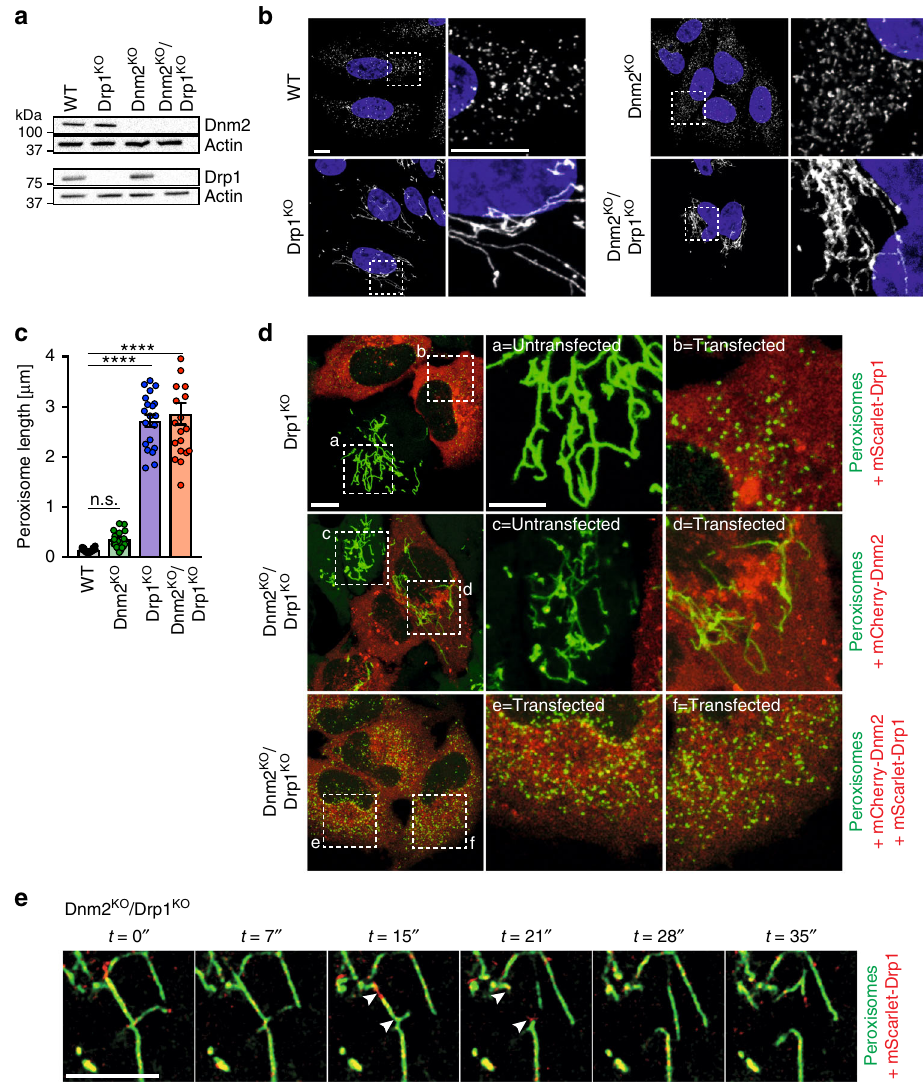
Fig. 1 Loss of Dnm2 does not affect division of peroxisomes. a Western blot analysis of HeLa WT, Dnm2 KO , Drp1 KO , and Dnm2 KO /Drp1 KO whole cell lysates. Actin was used as a loading control. b Confocal images of HeLa WT, Drp1 KO , Dnm2 KO , and Dnm2 KO /Drp1 KO cells subjected to immuno fl uorescence and stained for peroxisomes (Pex14, white). Blue marks the nucleus. An enlargement of the hatched box is shown on the right of each panel. Scale bar = 10 µ m. c Computational quanti fi cation of average peroxisome length in cell lines. n (WT) = 20 cells, n (Dnm2 KO ) = 20 cells, n (Drp1 KO ) = 20 cells, n (Dnm2 KO /Drp1 KO ) = 18 cells. Data obtained from three independent experiments. Data represents the mean ± S.E.M.; n.s., not signi fi cant; **** p < 0.0001. One-way ANOVA with multiple comparisons. d Confocal live-cell image stills of HeLa Drp1 KO and Dnm2 KO /Drp1 KO stably expressing Dendra2-SKL (green) and transfected with mCherry-Dnm2 (red) and/or doxycycline-inducible mScarlet-Drp1 (red) constructs. Enlargements of the hatched boxes depicting peroxisomal morphology in untransfected and transfected cells are shown on the right. Scale Bar = 10 µ m and 5 µ m (magni fi cations). e Confocal live-cell image stills of peroxisome fi ssion events in HeLa Dnm2 KO /Drp1 KO cells stably expressing Dendra2-SKL